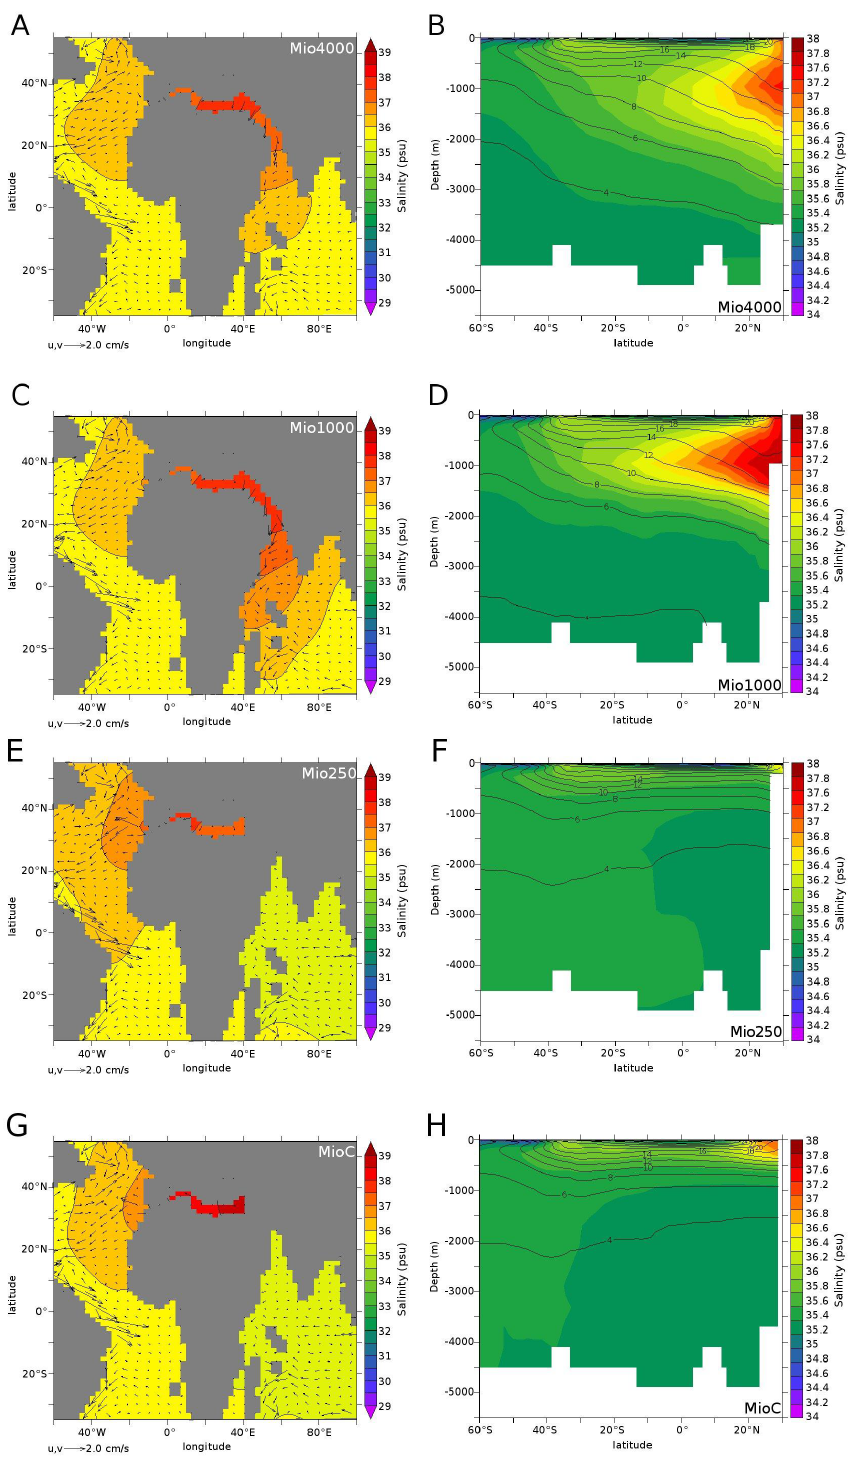
Fig. 7. (A, C, E, G) Simulated annual salinity at 952m and horizontal flow (cms − 1 ) for Mio4000, Mio1000, Mio250 and MioC, respectively. (B, D, F, H) Simulated salinity (shaded colours, psu) and temperature (isolines, ◦ C) as a function of depth averaged between 45 ◦ E and 60 ◦ E, for Mio4000, Mio1000, Mio250 and MioC,